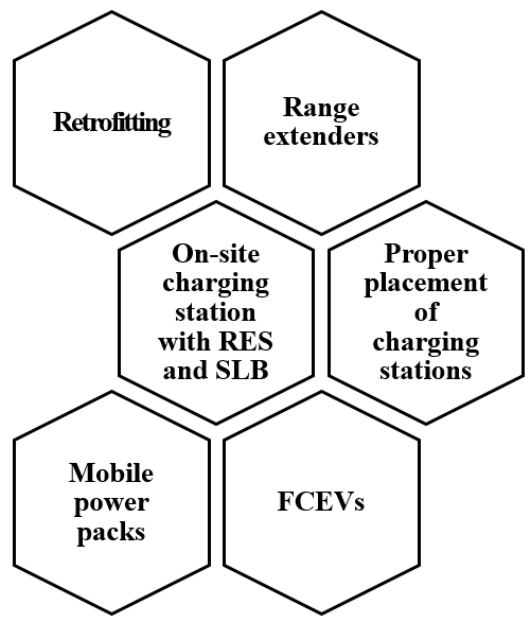
Figure 10. Potential technologies for facilitating off-road equipment electrification.